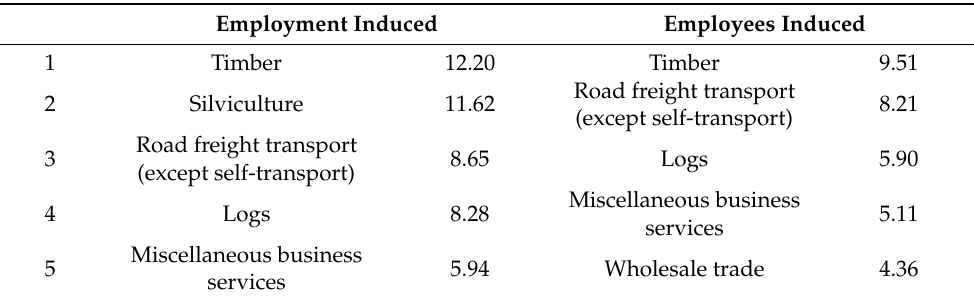
Table 4. Top five sectors with the largest employment impact in the CLT manufacturing sector (unit: people).